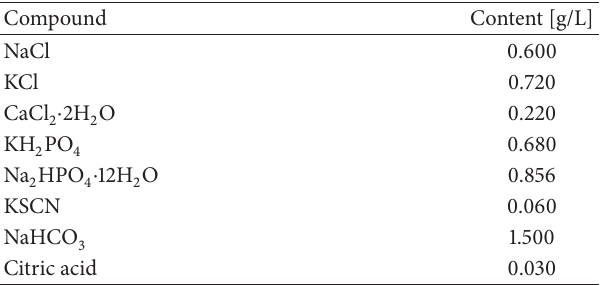
Table 1: Chemical composition of artificial saliva (pH = 6.5)